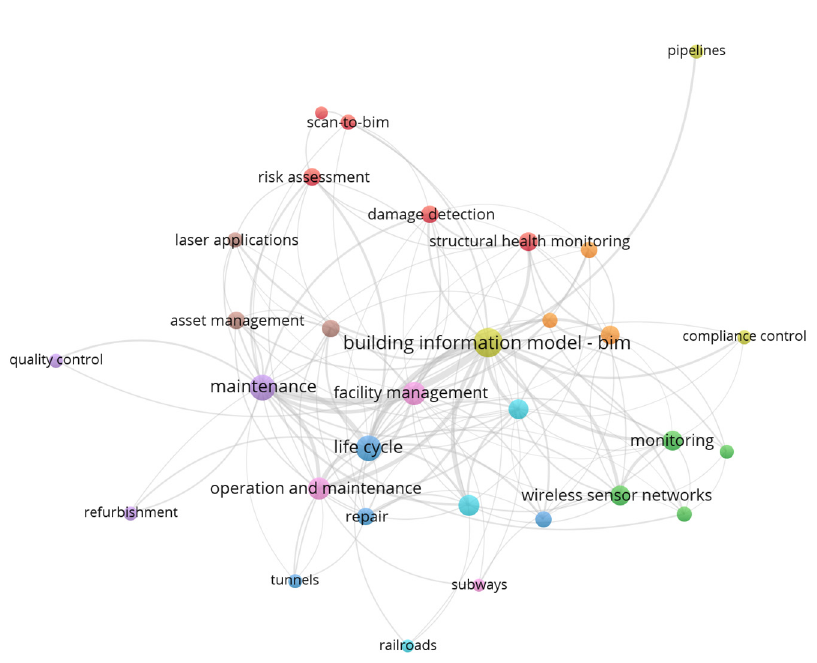
Figure 3. Frequency keywords